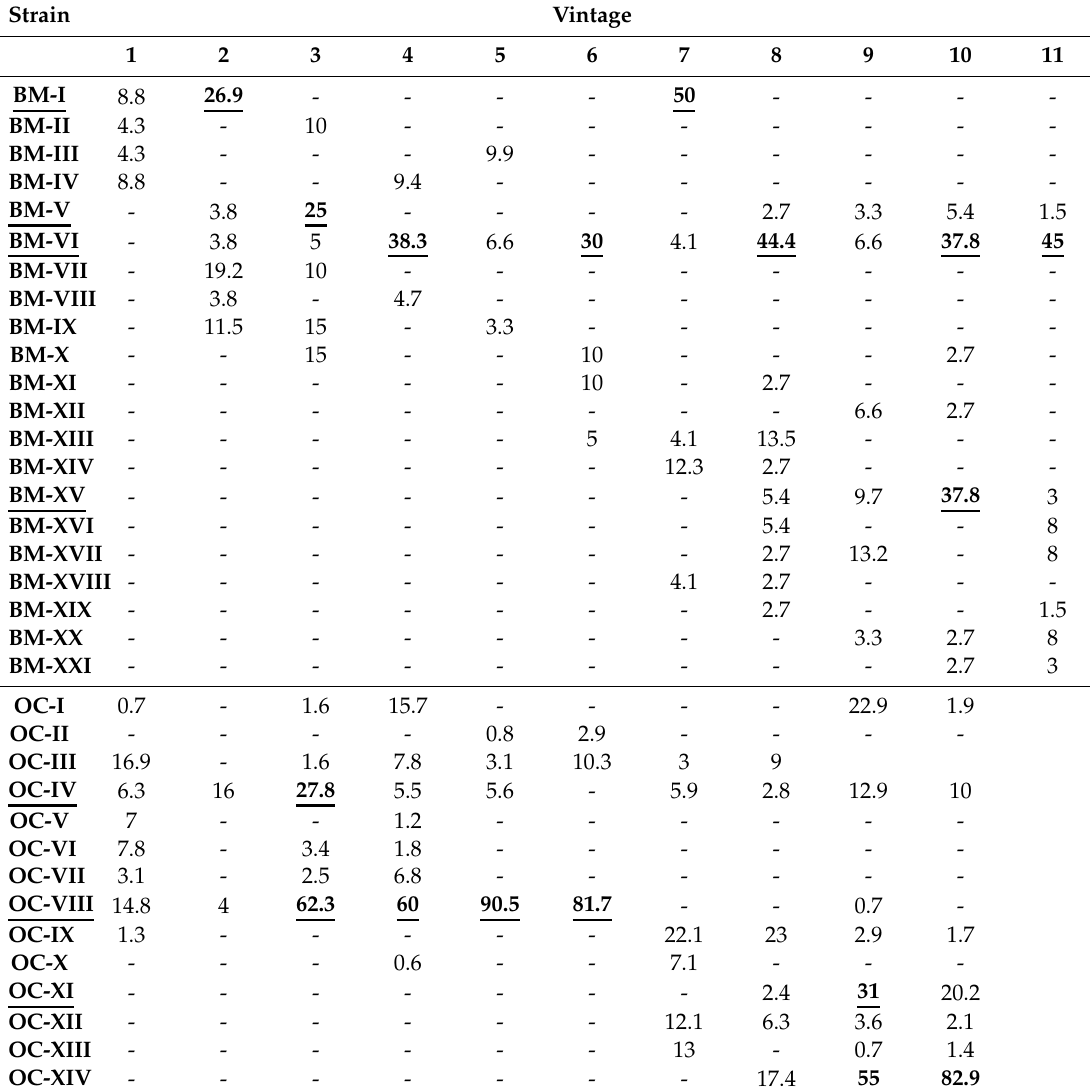
Table 4. Frequency (%) of S. cerevisiae strains recurring in two wineries (BM = Brunello di